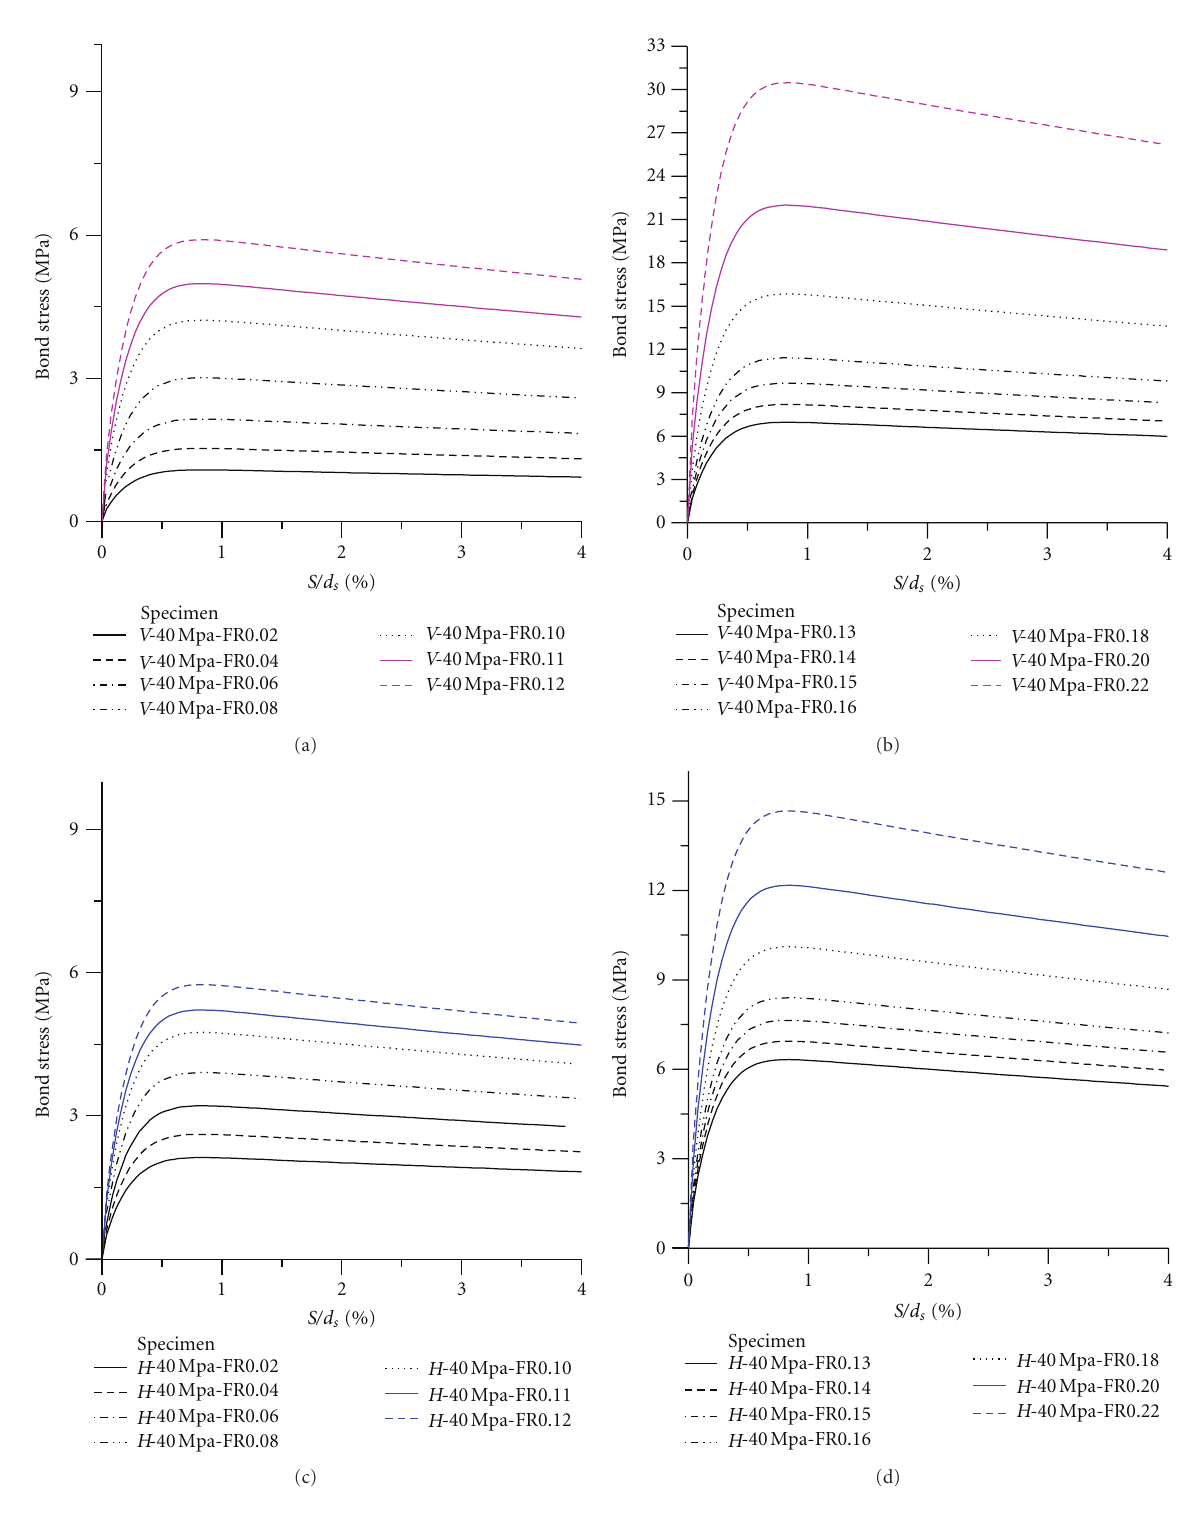
Figure 7: E ff ects of bond factors ( f (cid:3) c = 40MPa, 100 / A c =